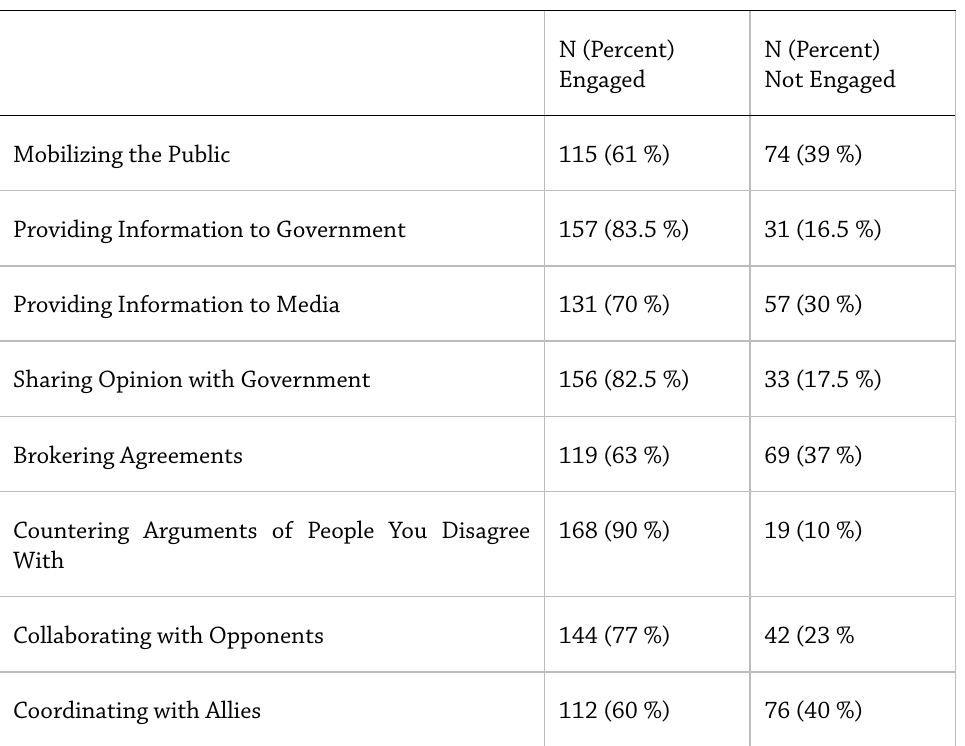
Table A1. Frequencies of Engagement in Reported Political Behaviors